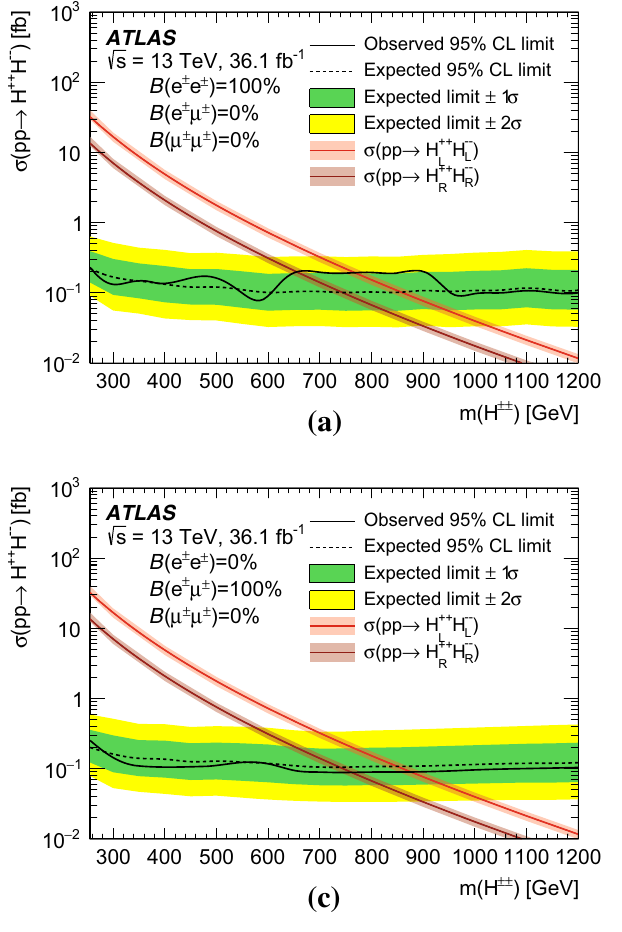
Fig. 10 Upper limit on the cross-section for pp → H ++ H −− for sev- eralbranching ratiovalues presentedintheform B ( ee )/ B ( e μ)/ B (μμ) :